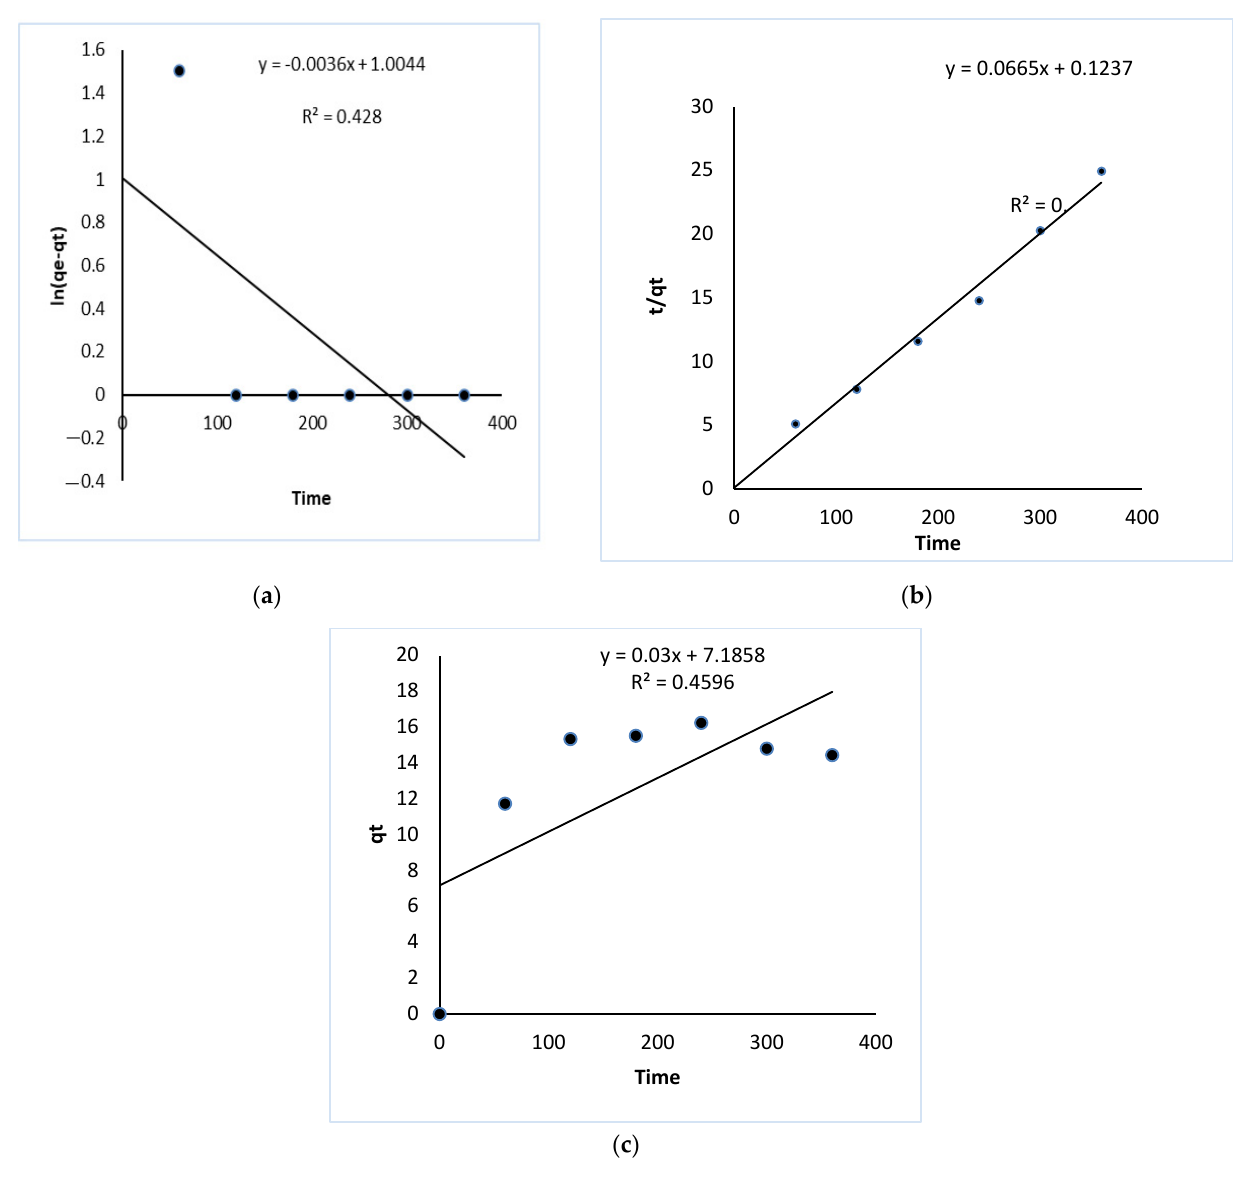
Table 4. Thermodynamic variables for PB dye adsorption by PFPB.